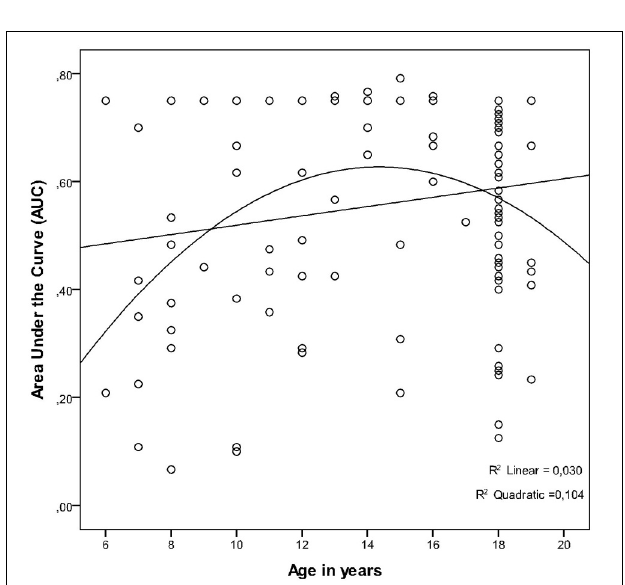
FIGURE 3 | The relation between age and ability/willingness to wait, as measured by Area Under the discounting Curve